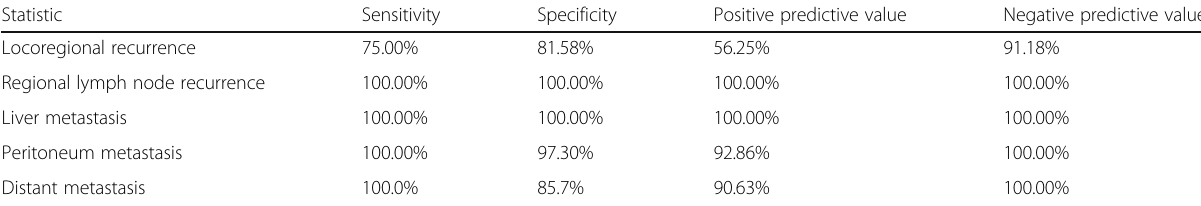
Table 3 Diagnostic performance of PET/CT on the organ-based analysis